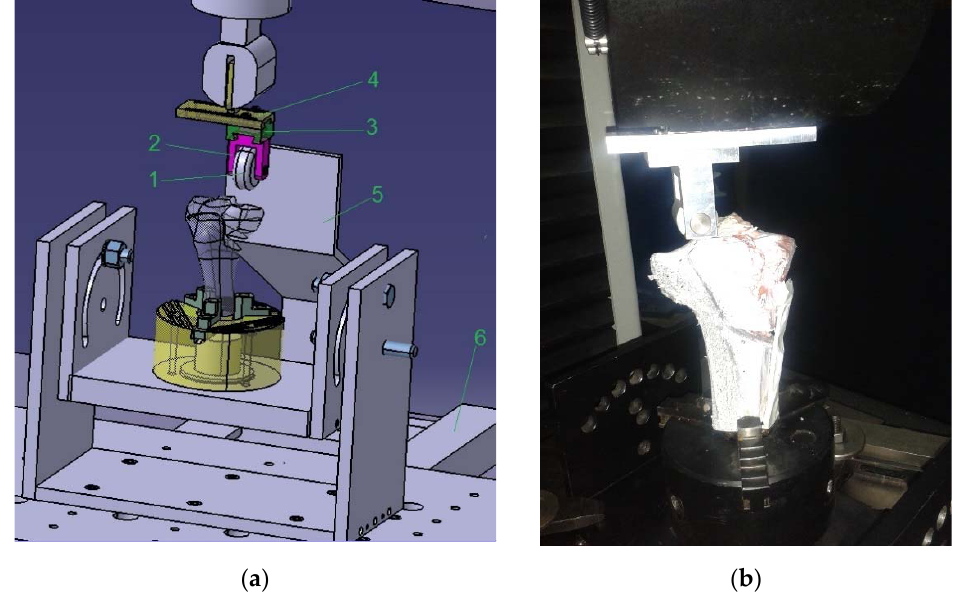
Figure 4. Experimental stand designed and modeled ( a ) and executed and prepared for the experi- ment ( b ).